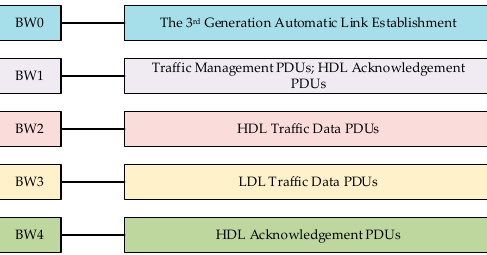
Figure 1. The five kinds of burst waveforms corresponding to different functions in the third- generation short-wave communication protocol. PDU: protocol data unit; HDL: high-rate data link protocol; LDL: low-rate data link.